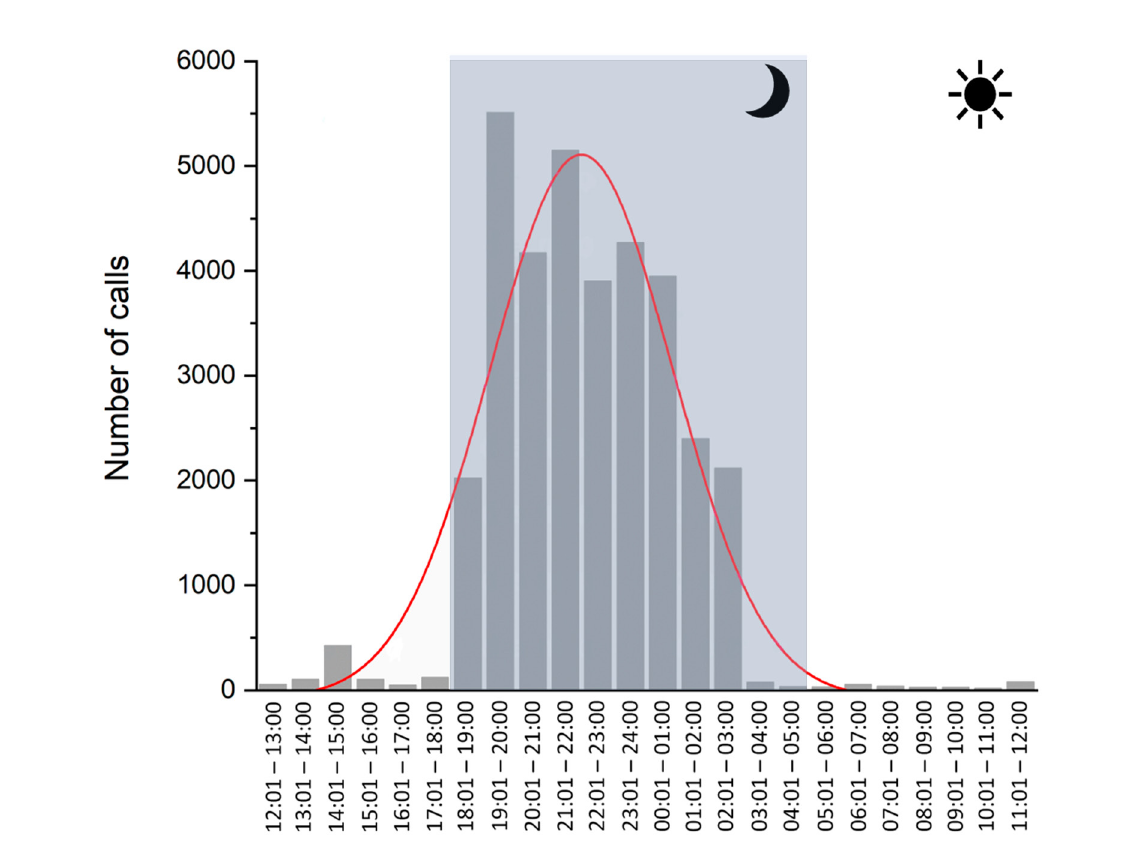
Fig. 10. Physalaemus araxa sp. nov. males calling activity per hour along one complete day in the top of the Caparaó National Park, municipality of Ibitirama, state of Espírito Santo, Brazil. The shaded blue indicates nocturnal period and the red line indicates the normal Gaussian fitted curve for the calling activity (adjusted after running the normality